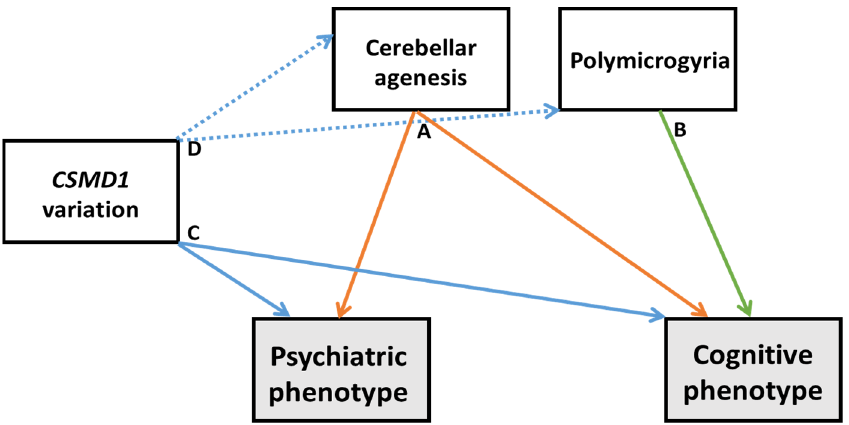
Figure 5. Hypotheses for the observed phenotype. Continuous lines indicate documented relationship between neuroanatomical, molecular and psychiatric/cognitive characteristics. In particular, option A indicates the contribution of cerebellar agenesis on the psychiatric and cognitive phenotypes; option B highlights the role of polymicrogyria in the observed cognitive profile; option C underlines the direct role of CSMD1 in the psychiatric and cognitive phenotypes. Dotted lines indicate a putative relationship between CSMD1 variations and the observed neuroanatomical features (option